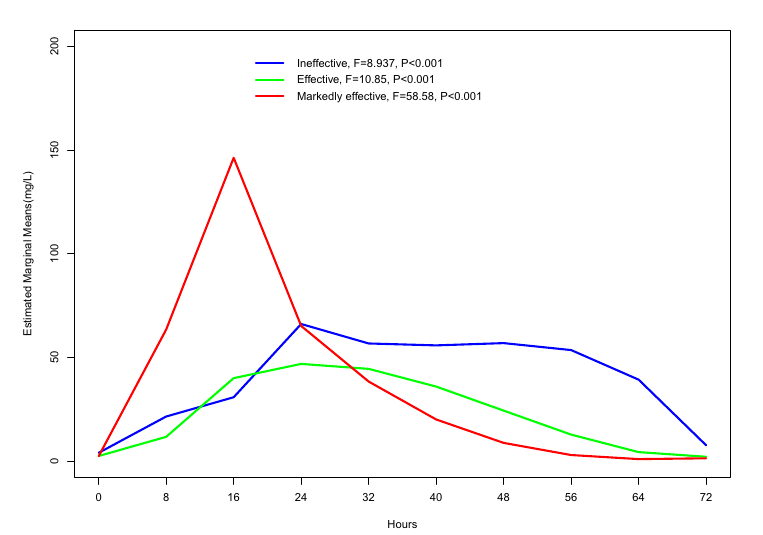
Figure 2. Spline regression curves for the repeated measurements of